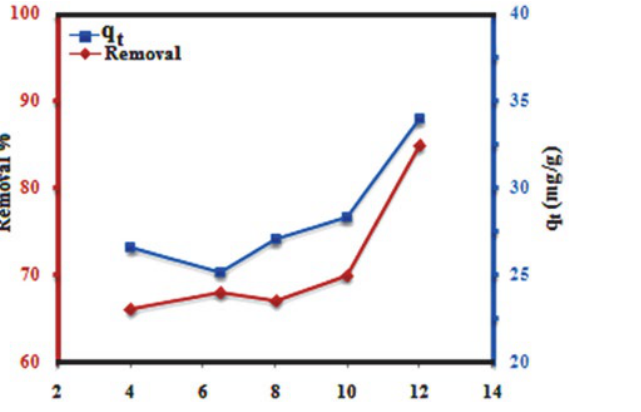
Figure 15. Van’t Hoff plots for the adsorption of MB onto GO/ Co O 3 4